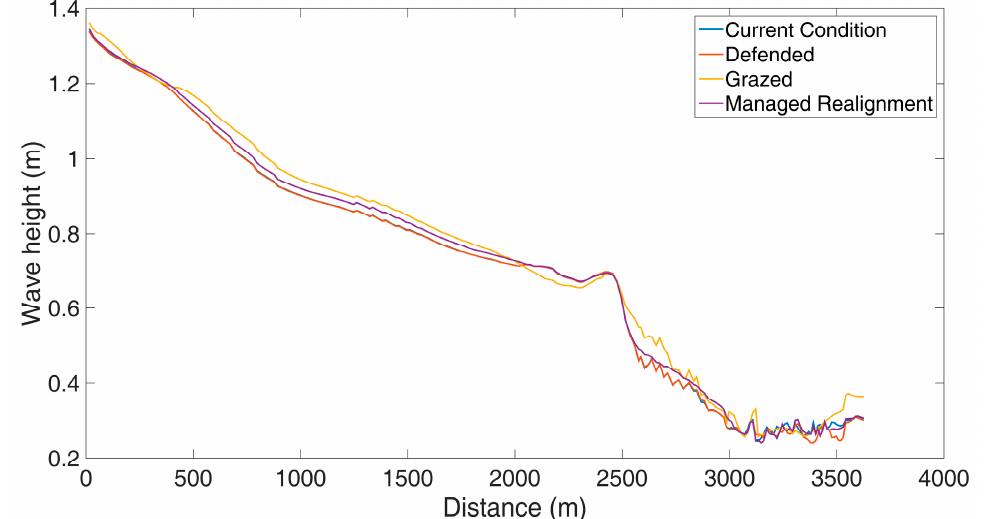
Figure 12. Comparison of peak storm wave height along T4 during the 1:50 year south-westerly storm. Distance is measured from the mouth of the estuary in Figure